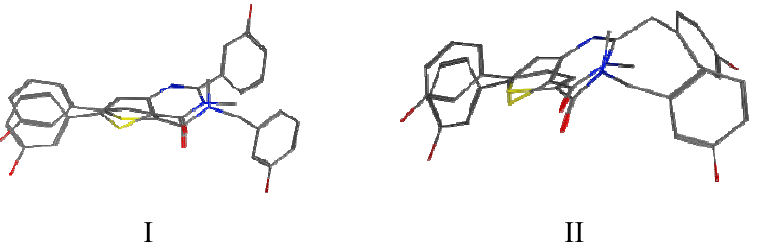
Figure 4. Superimposition between compounds 3b and B (Figure 4-I) and between compounds 3d and B (Figure